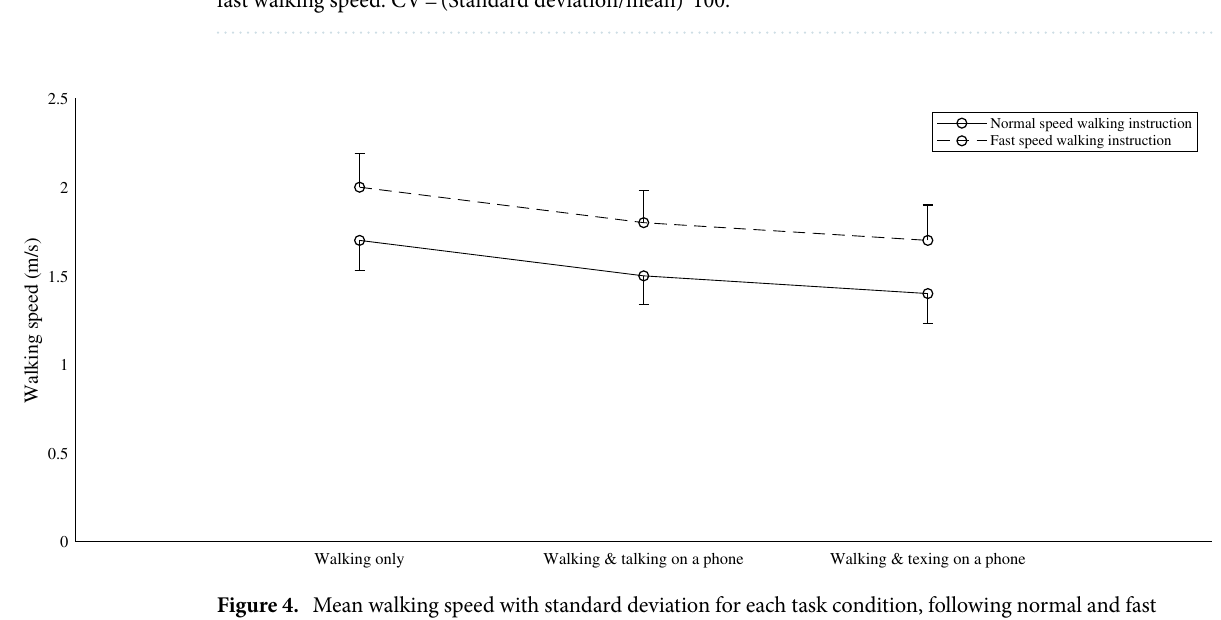
Figure 4. Mean walking speed with standard deviation for each task condition, following normal and fast walking speed